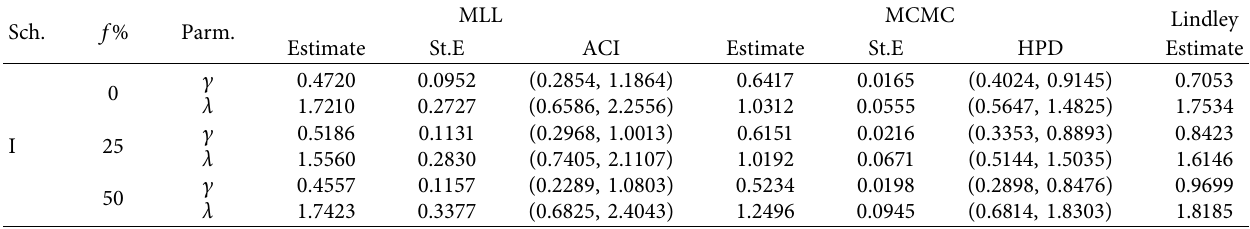
Table 8: MLL, Bayesian, and St.E and ACI based on the PCTI under various censoring schemes for data set I. Sch. f %